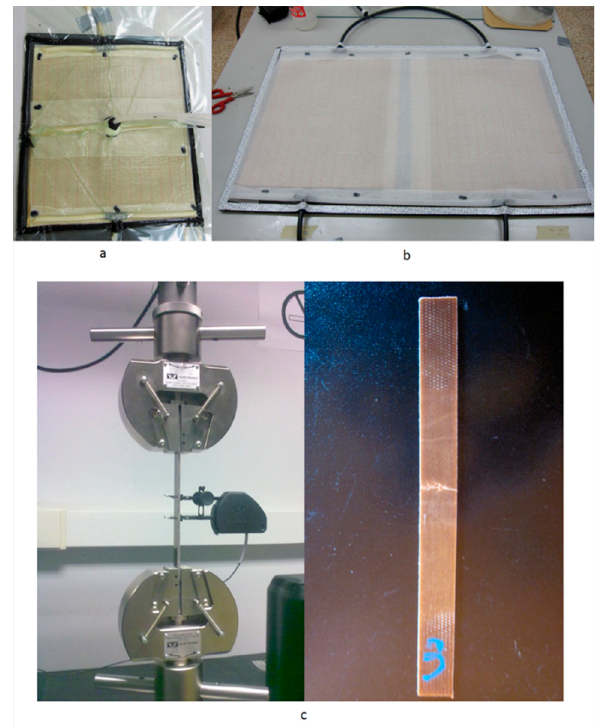
Figure 1. ( a ) Resin Transfer Molding (RTM) process; ( b ) production preparation; ( c ) tensile testing.